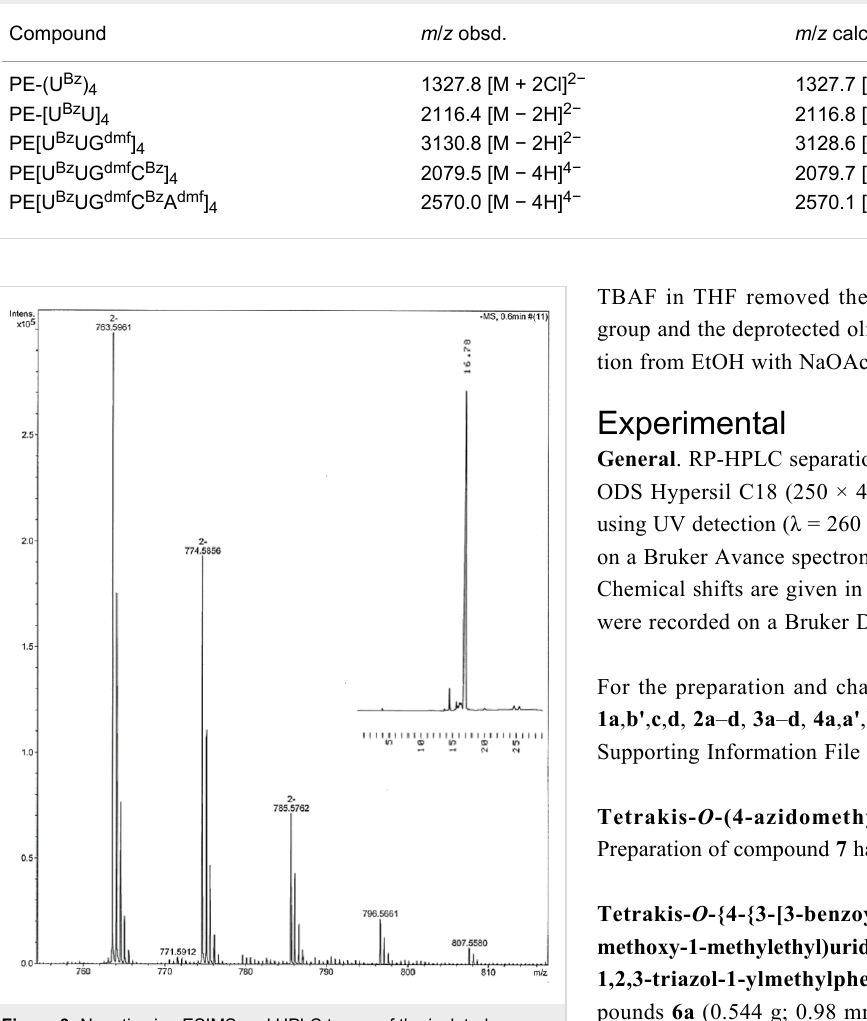
Figure 3: Negative ion ESIMS and HPLC traces of the isolated 3'-UUGCA-5'. For the MS over a wider mass range, see Supporting Information File 1. Chromatographic conditions: a Thermo ODS Hypersil C18 (250 × 4.6 mm, 5 µm) column eluted with a mixture